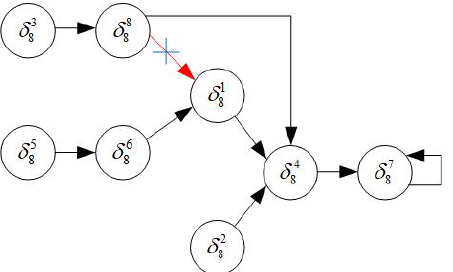
Figure 1. The state transfer graph of system (20) under P and the control (21) with s = 8, k ∗ = 2 and α (cid:48) ( 2,8 ) =